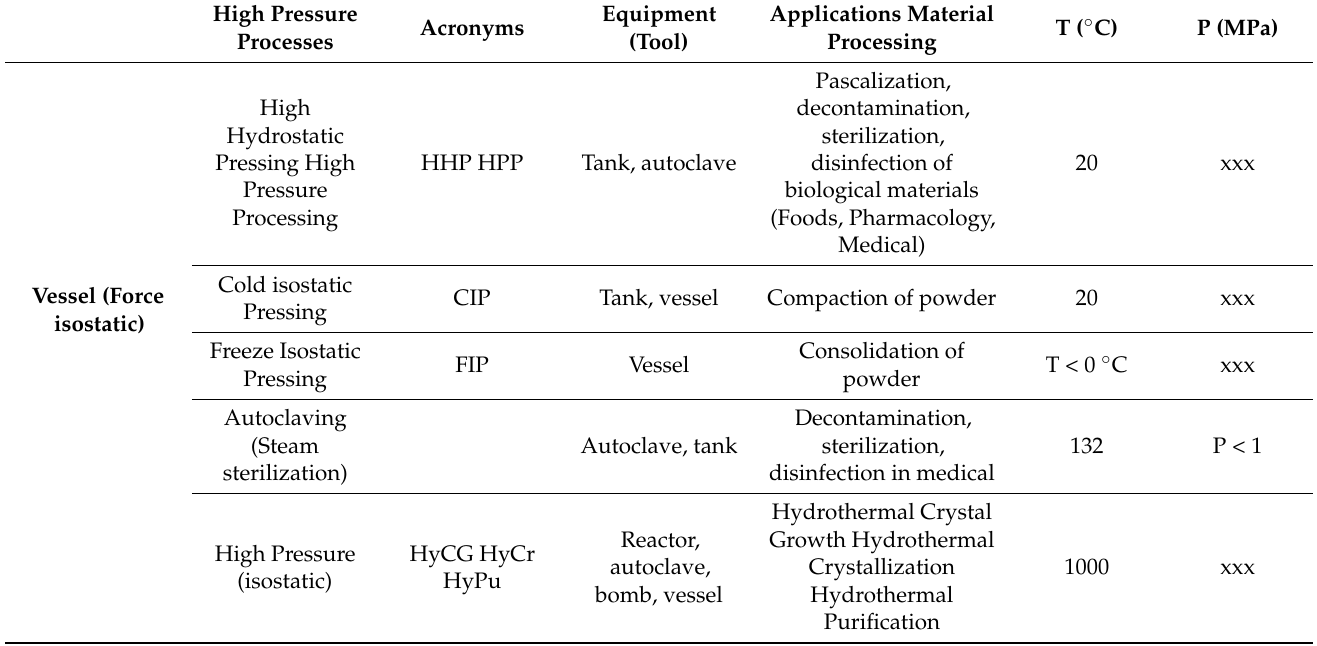
Table 1. High-pressure processing techniques used for materials